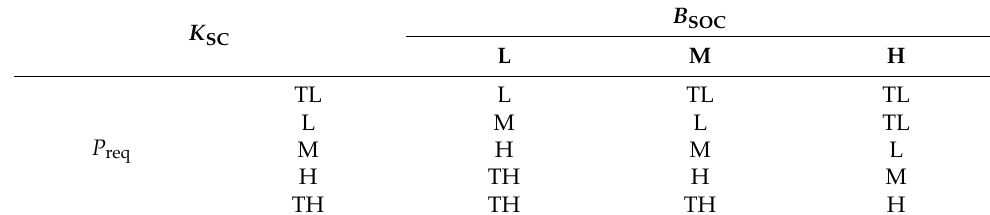
Table 5. Fuzzy control rules ( S SOC = H).